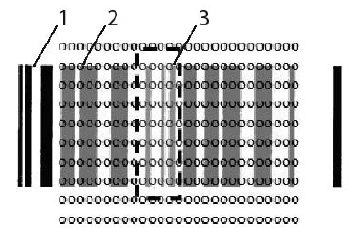
Fig. 2. Principal system of calibration: 1 – coded bars of the staff; 2 – array of CCD sensors; 3 – analyzing window